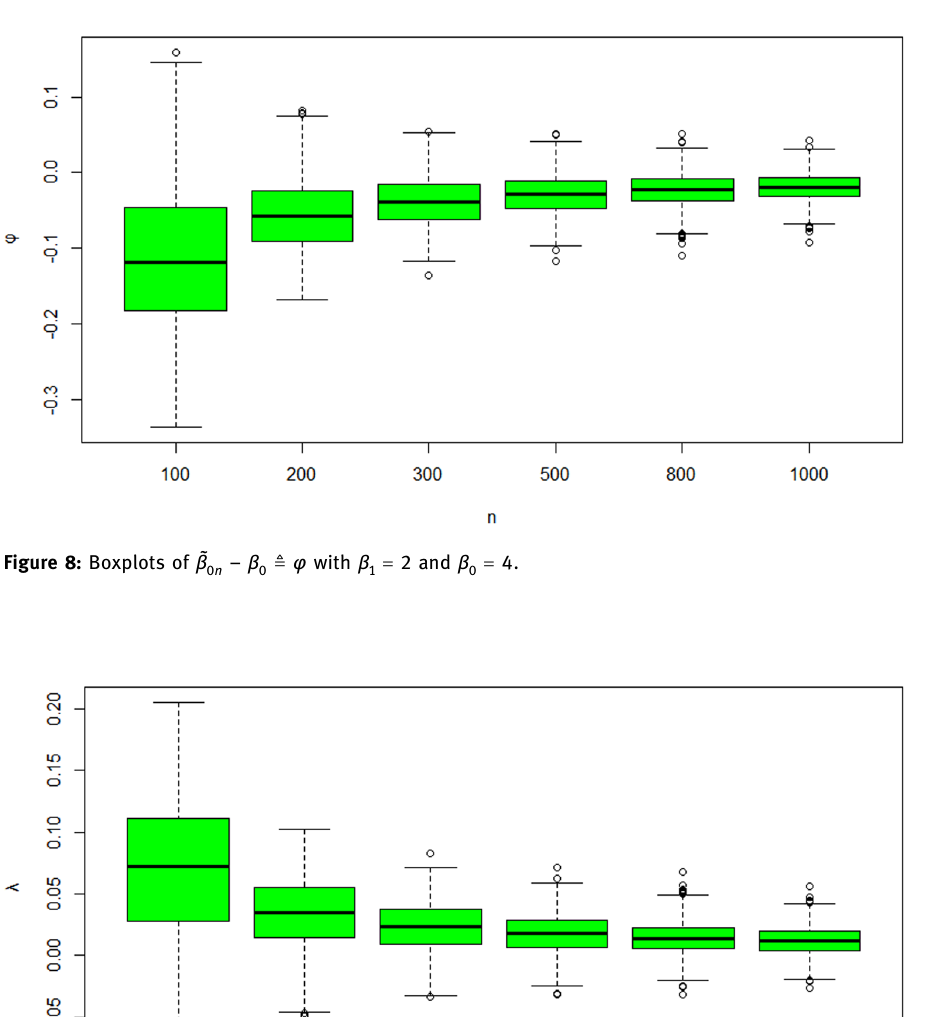
Figure 9: Boxplots of ≜ β β λ ˜ −